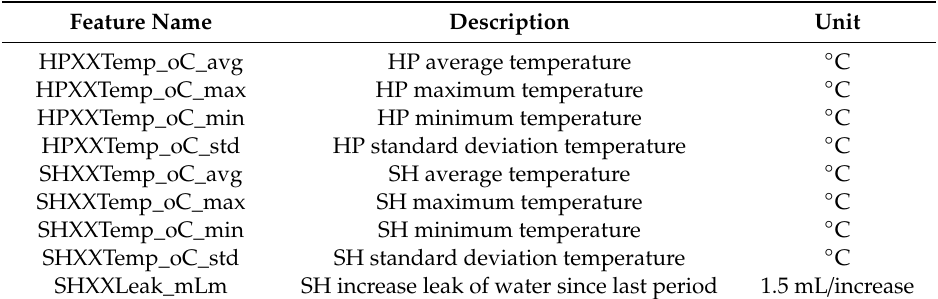
Table 1. Intensifier features. Variables gathered from each cylinder, SH and HP. XX in the feature name refers to the number of each sensor.